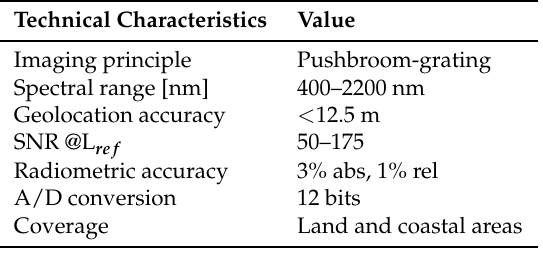
Table 1. MSI/Sentinel-2 sensor characteristics as per [41].